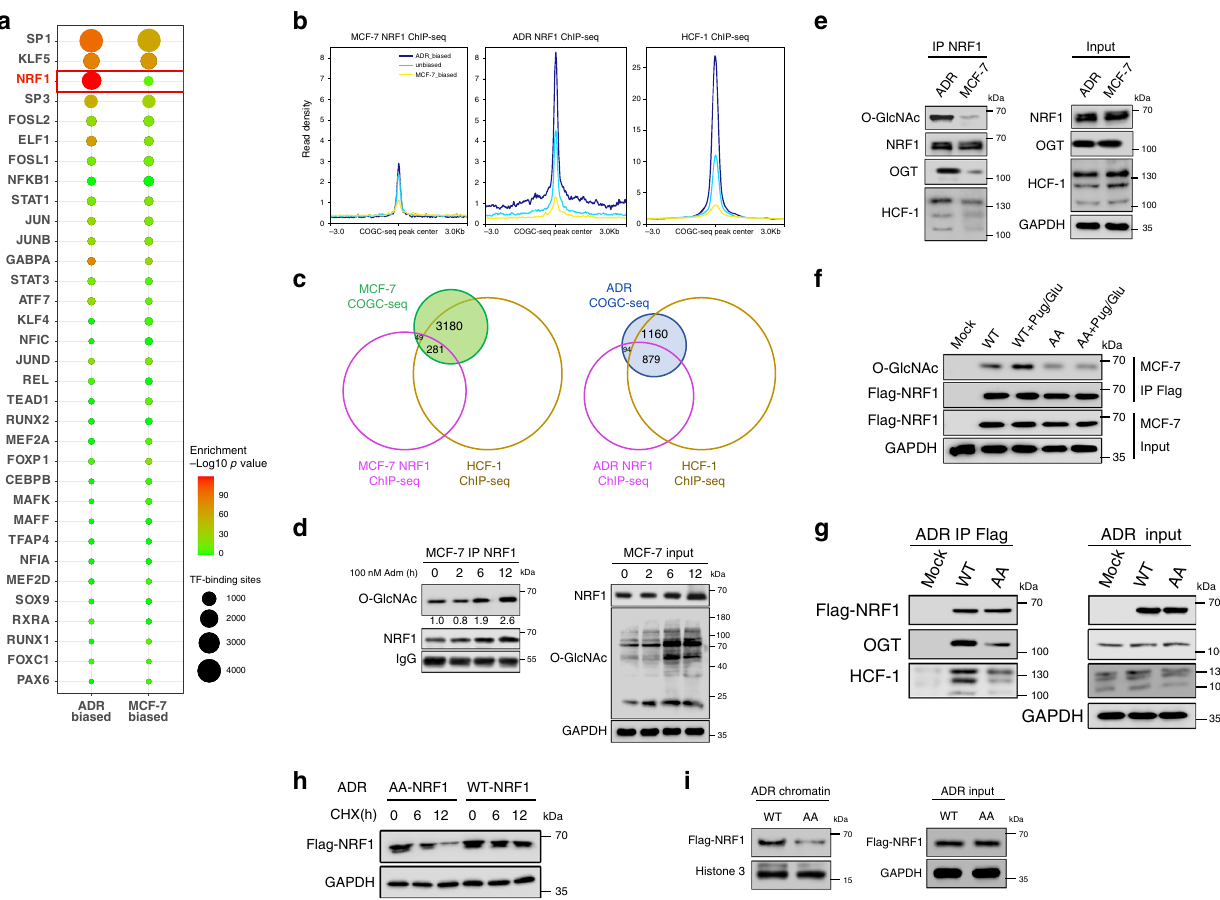
Fig. 6 O-GlcNAc enhances the stability and chromatin binding of NRF1 during the response to genotoxic stress. a The chromatin binding sites and enrichment of 33 responsive OCTFs generated through a motif enrichment analysis of MCF-7- and ADR-biased COGC-seq peaks are shown in a heat map. The color of the dots represents the TF motif enrichment. More TF-binding sites are indicated by a large dot size. b Average enrichment pro fi les of NRF1 ChIP-seq reads (MCF-7 and ADR cells) and published HCF-1 ChIP-seq reads (MCF-7, GSE91992) at differential quantitative COGC-seq peaks. c COGC- seq peaks in MCF-7 and ADR cells overlap with NRF1 and a published HCF-1 (GSE91992) ChIP-seq dataset. d O-GlcNAc NRF1 was upregulated in MCF-7 cells after transient stimulation with 100 nM Adm. IP of NRF1 was performed, and the immunoprecipitated fractions were analyzed by immunoblotting for O-GlcNAc (CTD110.6). e The NRF1-HCF-1 interaction is increased in ADR cells compared with MCF-7 cells. NRF1 co-IP was performed, and the immunoprecipitated fractions were analyzed by immunoblotting for the indicated proteins. f NRF-1 is O-GlcNAcylated at Ser448/Ser451. After treatment with PugNAc (Pug, 100 μ M) and glucose (Glu, 25 mM) for 24 h, MCF-7 cells stably expressing Flag-WT-NRF1 or Flag-AA-NRF1 were immunoprecipitated with anti-Flag magnetic beads. O-GlcNAcylation (CTD110.6) was analyzed by immunoblotting. WT, wild-type NRF1; AA, Ser447/Ser450 → Ala mutational NRF1. Mock, cells transfected with empty pCMVPuro64 vector. g O-GlcNAc promotes the interaction of HCF-1 and OGT with NRF1. Immunoblotting showing the PPIs of endogenous HCF-1 and OGT with NRF1 in ADR cells. ADR cells stably expressing Flag-WT-NRF1 or Flag-AA-NRF1 were immunoprecipitated with anti-Flag magnetic beads. h O-GlcNAc inhibition expedites the degradation of NRF1. ADR cells expressing Flag-WT-NRF1 or Flag- AA-NRF1 were incubated with 50 μ M cycloheximide (CHX) for up to 12 h. The expression levels of Flag-NRF1 were monitored by immunoblotting. i O- GlcNAc enhances the chromatin binding of NRF1. The crosslinked chromatin proteins were extracted, and the levels of Flag-NRF1 were detected by immunoblotting. For ( d – i ), all blots are representative of at least two biologically independent experiments. a , d – i Source Data are provided as a Source Data fi with an O-GlcNAc-speci fi c antibody after 6 h of Adm stimula- tion, and this detection was accompanied by the accumulation of total NRF1 (Fig. 6d). The amount of modi fi ed NRF1 in MCF-7 cells treated with Adm was signi fi cantly higher after 12 h, which indicates the potential regulatory function of O-GlcNAc at this time point. To further eliminate the nonspeci fi c immunostaining of the anti-O-GlcNAc antibody, an O-GlcNAc enzymatic labeling system 46 , which recognizes terminal GlcNAcs with high speci fi - city, was employed to con fi rm the modi fi cation of O-GlcNAc on endogenous NRF1 in MCF-7 and ADR cells (Supplementary Fig. 19).